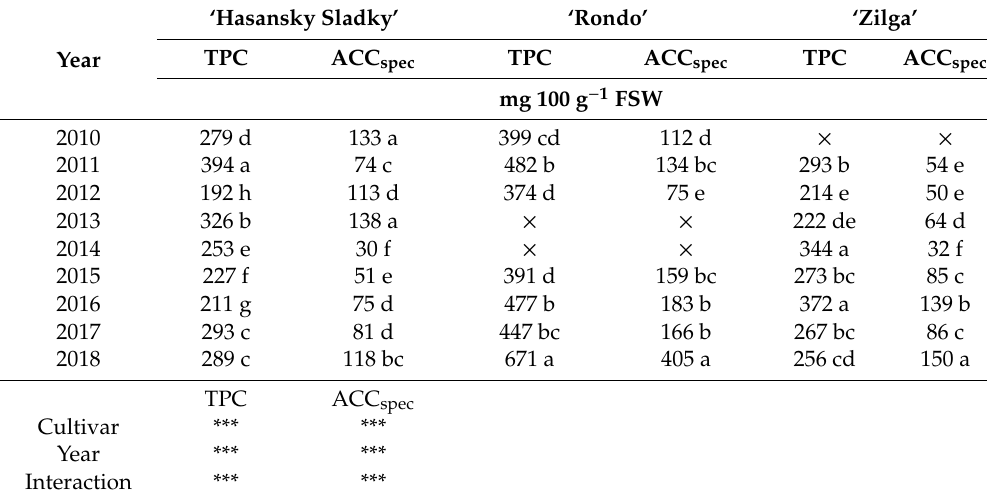
Table 4. The e ff ect of year and cultivar on phenolic compounds of grape cultivars ‘Hasansky Sladky’, ‘Rondo’ and ‘Zilga’ (2010–2018) cultivated in field